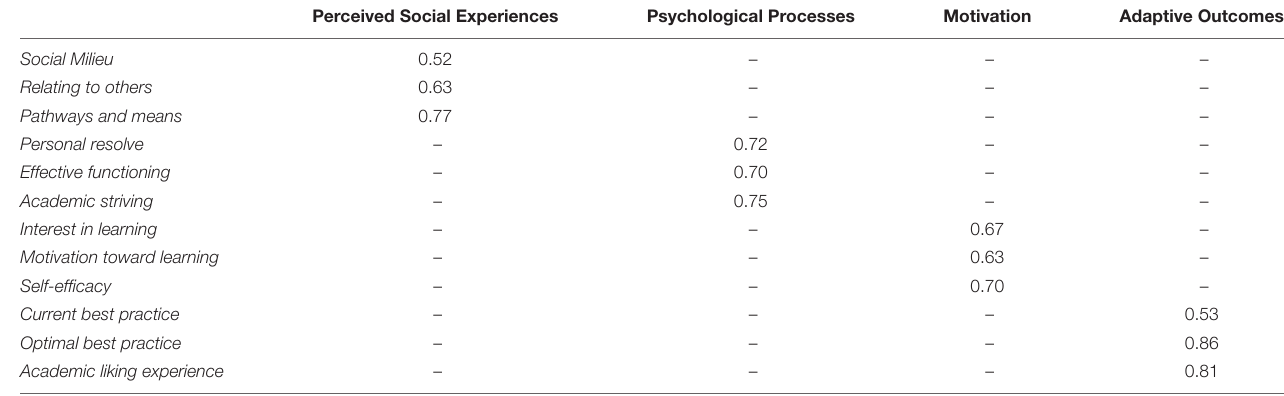
TABLE 4 | Factor loadings for a four-factor